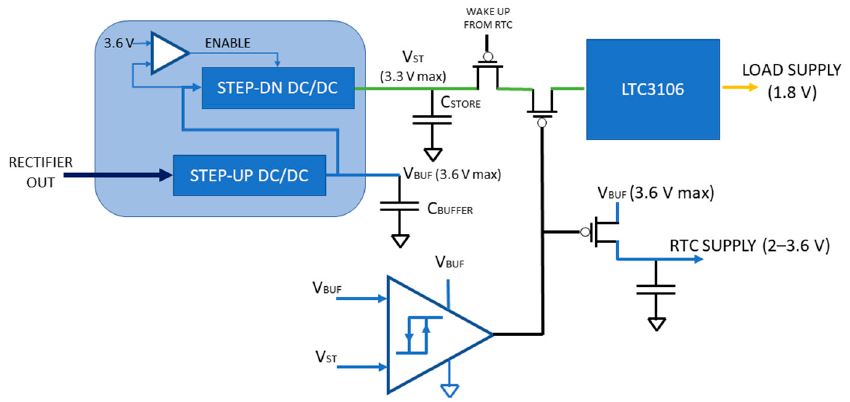
Figure 7. Scheme of the power management section of the wireless sensor node.